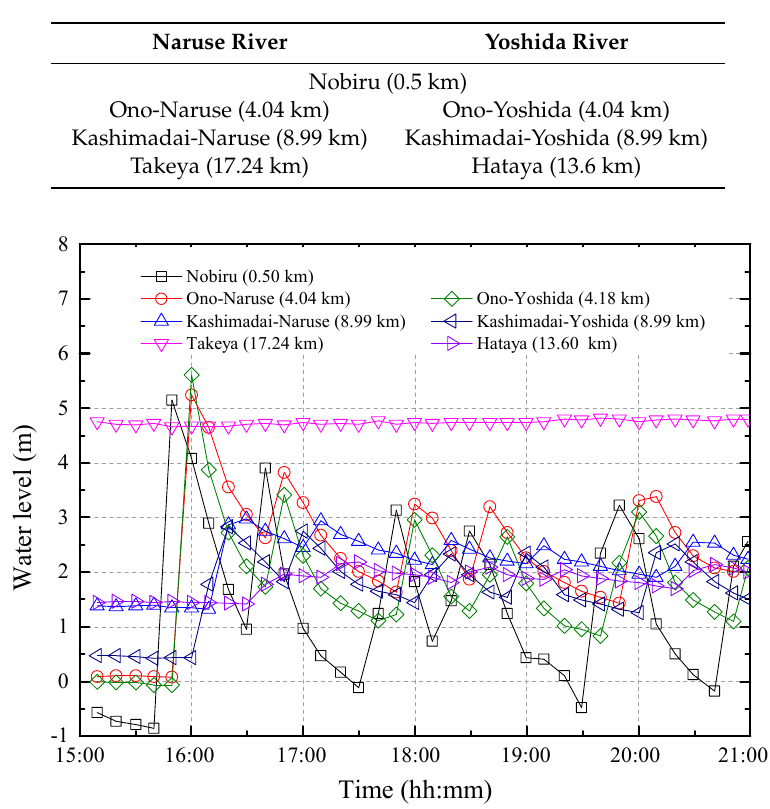
Figure 10. Measured water level data along Naruse and Yoshida Rivers (11 March 2011).